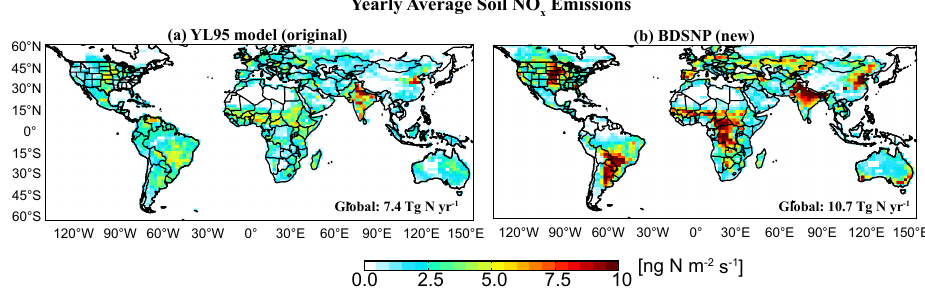
Fig. 1. Comparison of above-soil NO x emission inventories. Emissions calculated from (a) the original YL95 parameterization as imple- mented into GEOS-Chem (Wang et al., 1998) are compared with (b) the updated model (BDSNP) for the year 2006. Calculated global 2006 emissions are listed (lower right). Color bar saturates at 10 ngNm − 2 s − 1 .